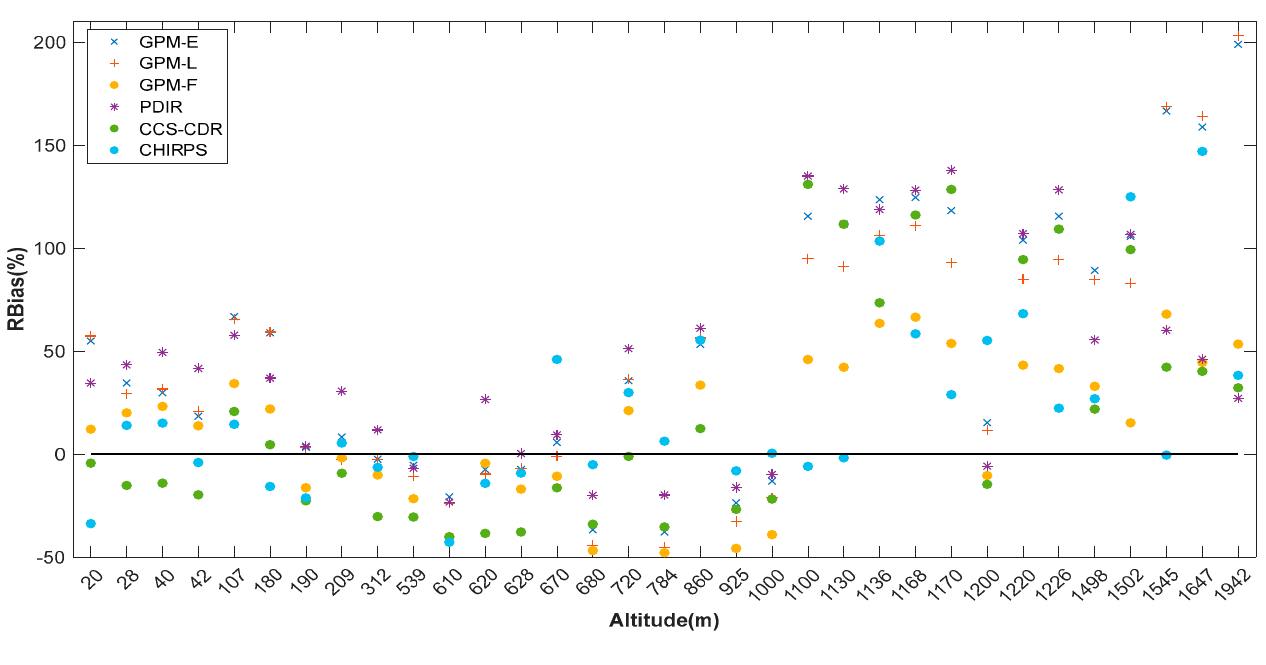
10 of 22 Figure 3. Boxplot of three continuous metrics at daily, monthly and annual time scales. •